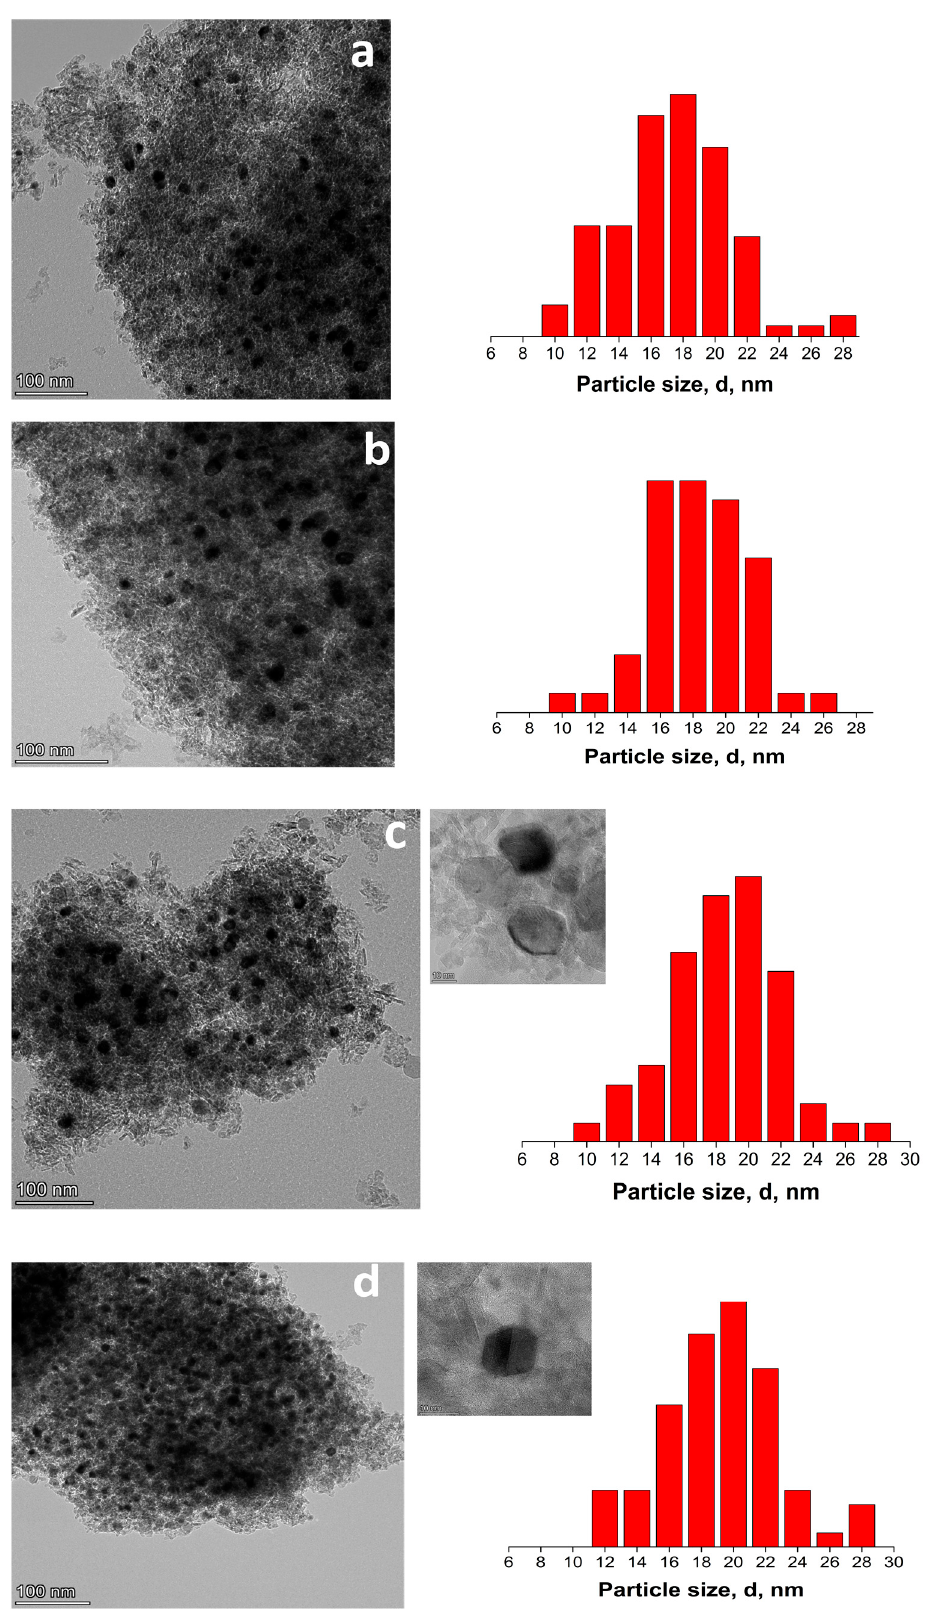
Figure 3. HRTEM images and distribution histograms of nickel particles of the reduced (H 2 , 700 °C) catalysts: ( a ) NiMg 4 Al 2 -HT, ( b ) Ni 1.3 Mg 3.7 Al 2 -HT, ( c ) Ni 1.6 Mg 3.4 Al 2 -HT, and ( d ) Ni 2 Mg 3 Al 2